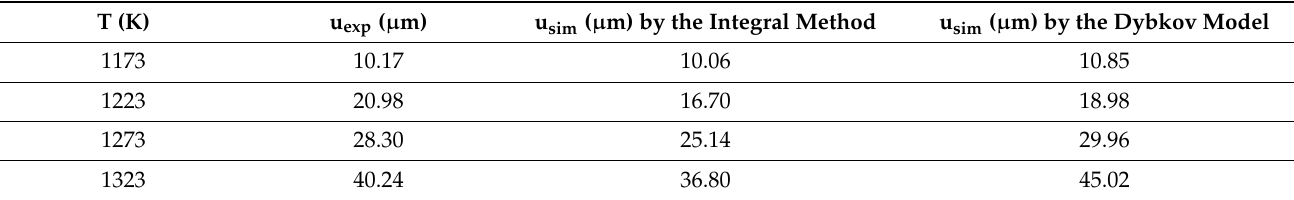
Table 6. Experimental and predicted layers’ thicknesses of FeB for 10 h at different